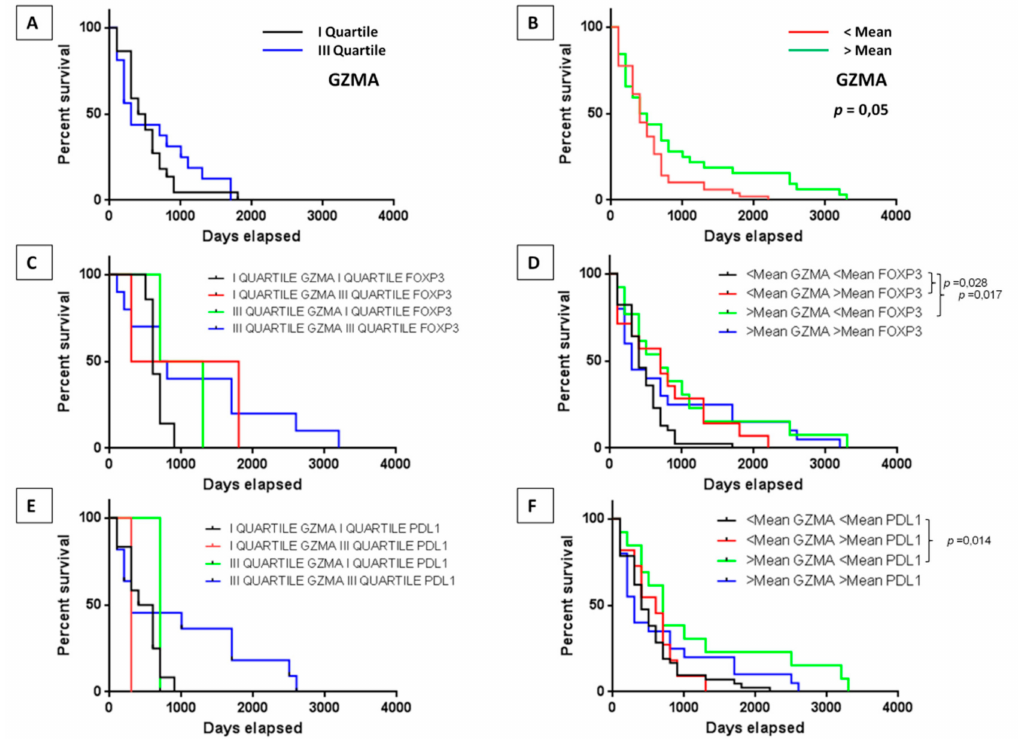
Figure 6. Microenvironment and survival. Survival of HCC patients with high and low gene expression of Granzyme alone or in association with FoxP3 or PDL1 in the validation set. The association was evaluated considering the value in the I and the III quartiles ( A , C , E ) as well as the value below and above the mean ( B , D , F